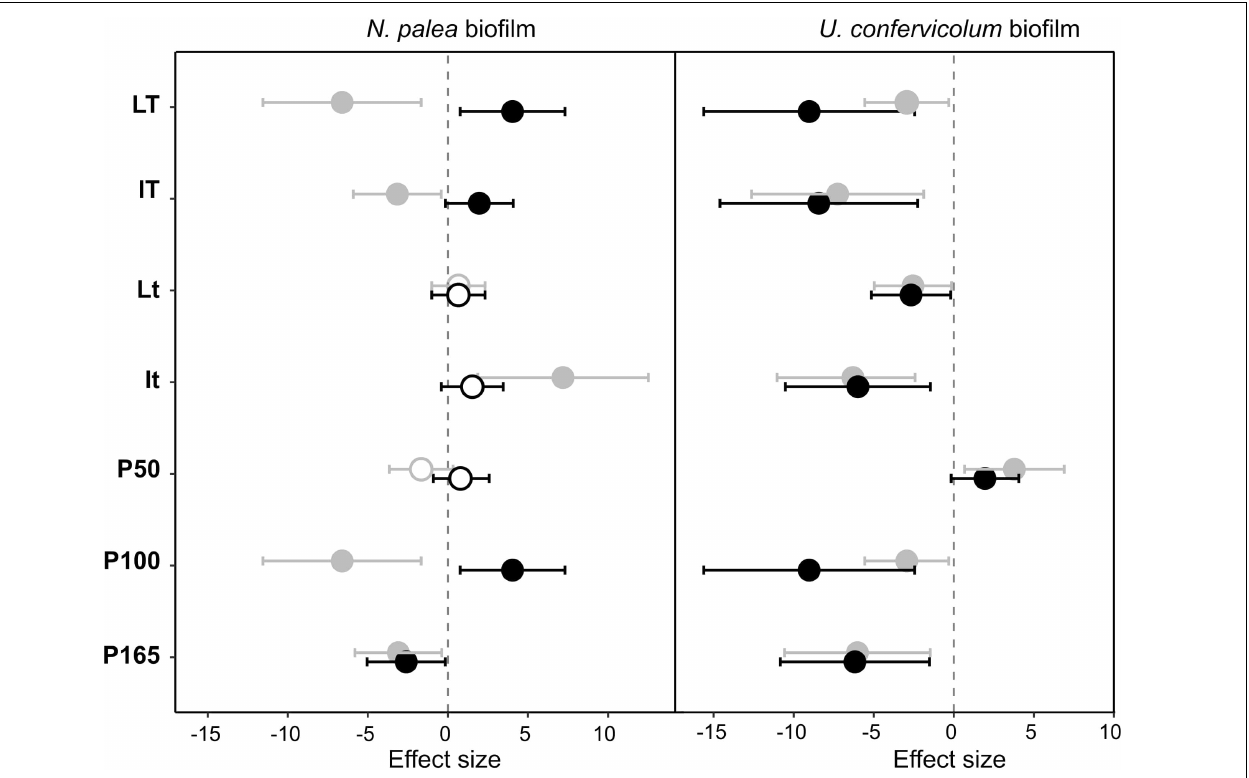
FIGURE 4 | Effect size (Hedges’s ± 95% confidence interval) on the total organic carbon (EPS quantity) measured before the disturbance and at the end of the disturbance (gray circles) or before the disturbance and at the end of the rewetting period (black circles), for the N. palea biofilm and U. confervicolum biofilm. The effect size was measured for each growth condition. Full circles: significant effects, open circles: non-significant effects. L / l : high/low light intensity (P100), T / t : high/low temperature (P100), P50, P100, P165: 50, 100, and 165% of the standard initial phosphorous concentration, respectively, associated with L and T